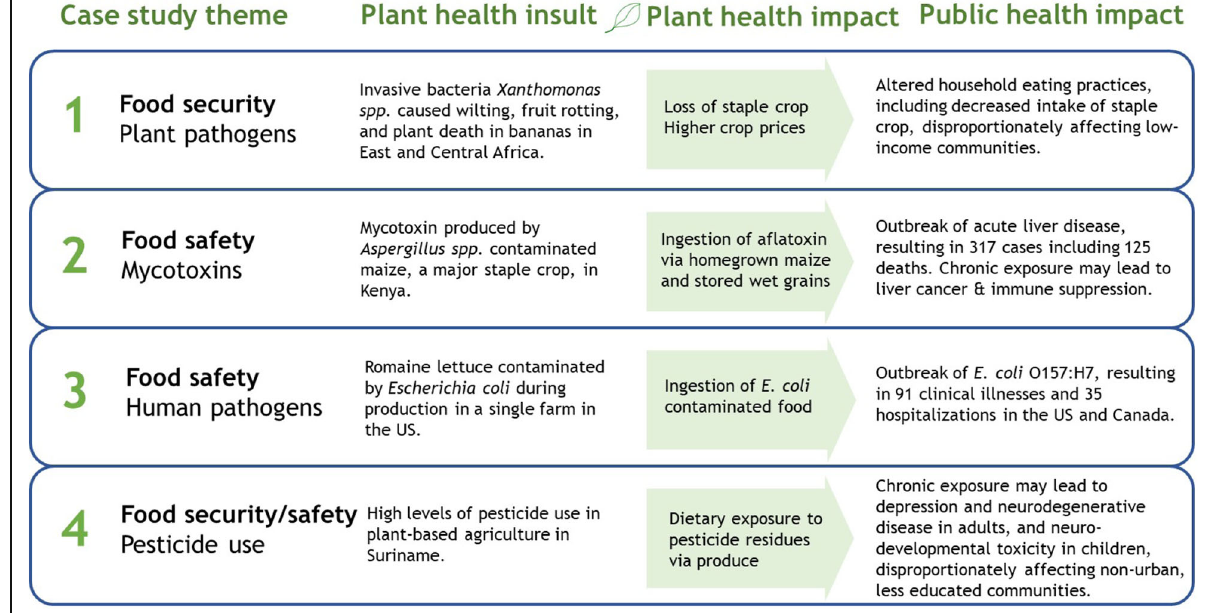
Fig. 2 Case studies and linkages to One Health as discussed in the text. The studies illustrate different examples of the interconnectedness of plant, animal and human health, and the negative consequences of plant health problems to public